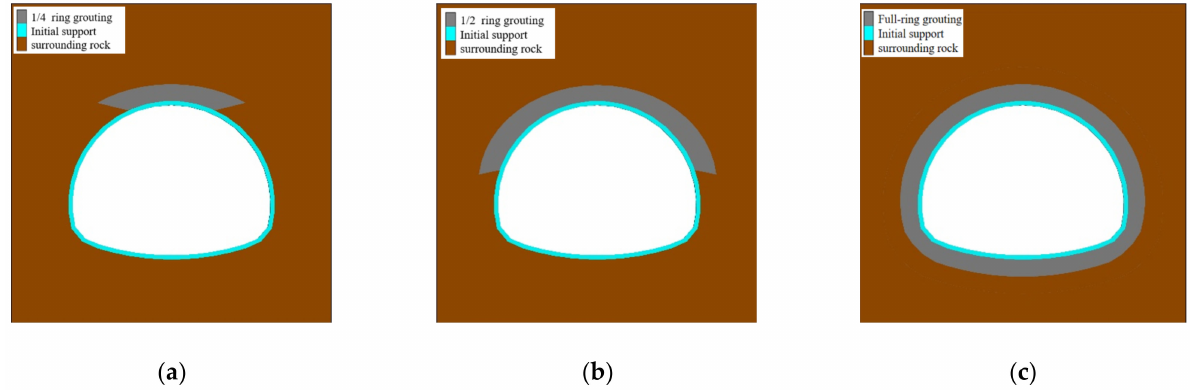
Figure 3. Schemes of grouting. ( a ) 1/4 ring grouting; ( b ) 1/2 ring grouting; ( c ) Full-ring